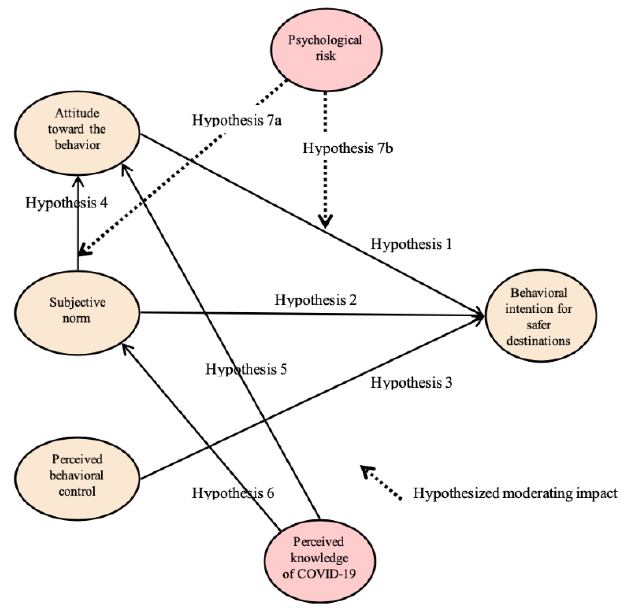
Figure 1. Proposed theoretical model. H1: The attitude toward the behavior has a positive impact on the behavioral intentions for safer destinations among US international travelers. H2: The subjective norm has a positive impact on the behavioral intentions for safer destinations among US international travelers. H3: The perceived behavioral control has a positive impact on the behavioral intentions for safer destinations among US international travelers. H4: The subjective norm has a positive impact on the attitude toward behaviors among US international travelers. H5: The perceived knowledge of COVID-19 has a positive impact on the attitude toward behaviors among US international travelers. H6: The perceived knowledge of COVID-19 has a positive impact on the subjective norm among US international travelers. H7a: The psychological risk significantly moderates the relationship between the subjective norm and the attitude toward behaviors among US international